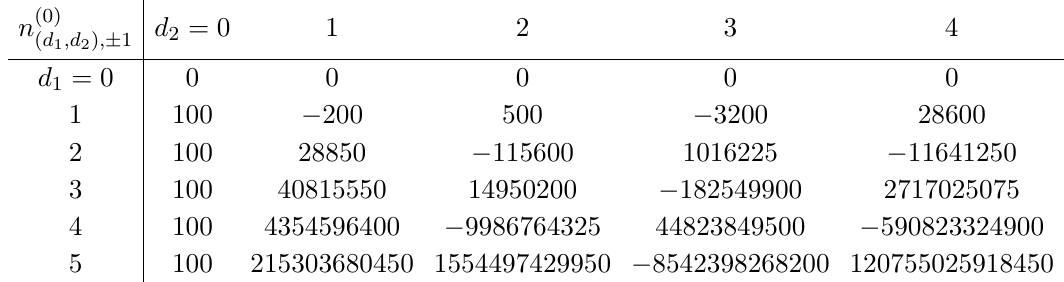
with Z charge ± 1 5 0